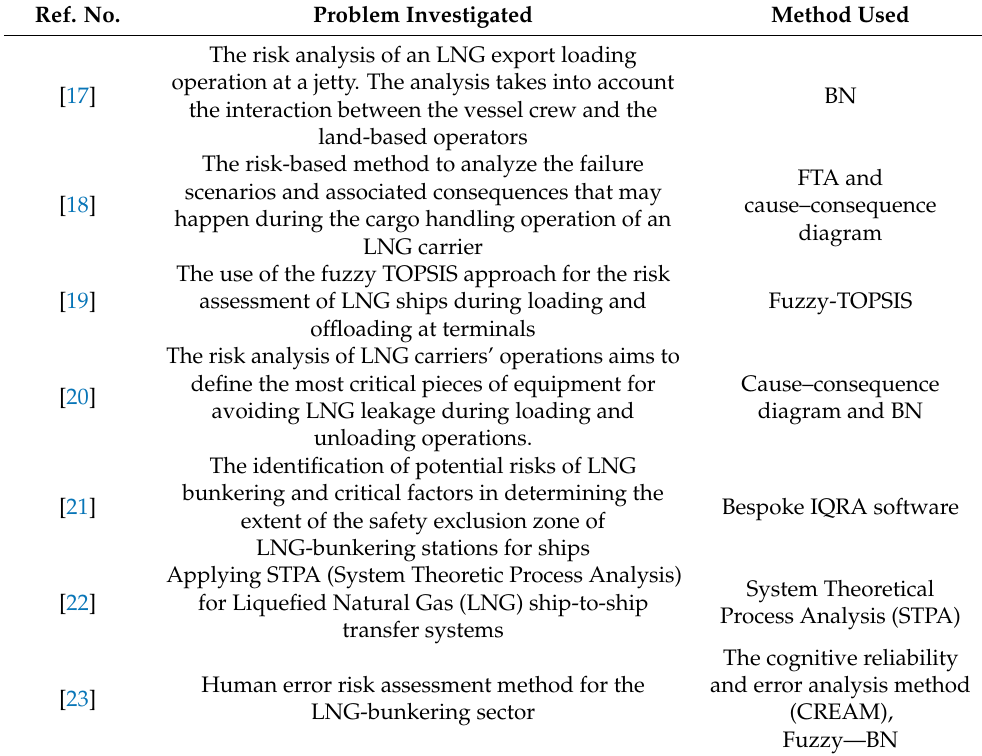
Table 2. Literature review for research Area 2—Risk related to LNG reloading operations.